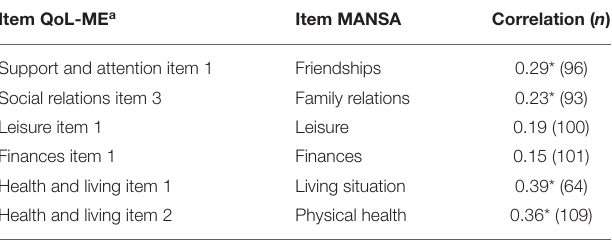
TABLE 4 | Pearson correlations between six pairs of items of the additional modules of the QoL-ME and corresponding MANSA items. Item QoL-ME a